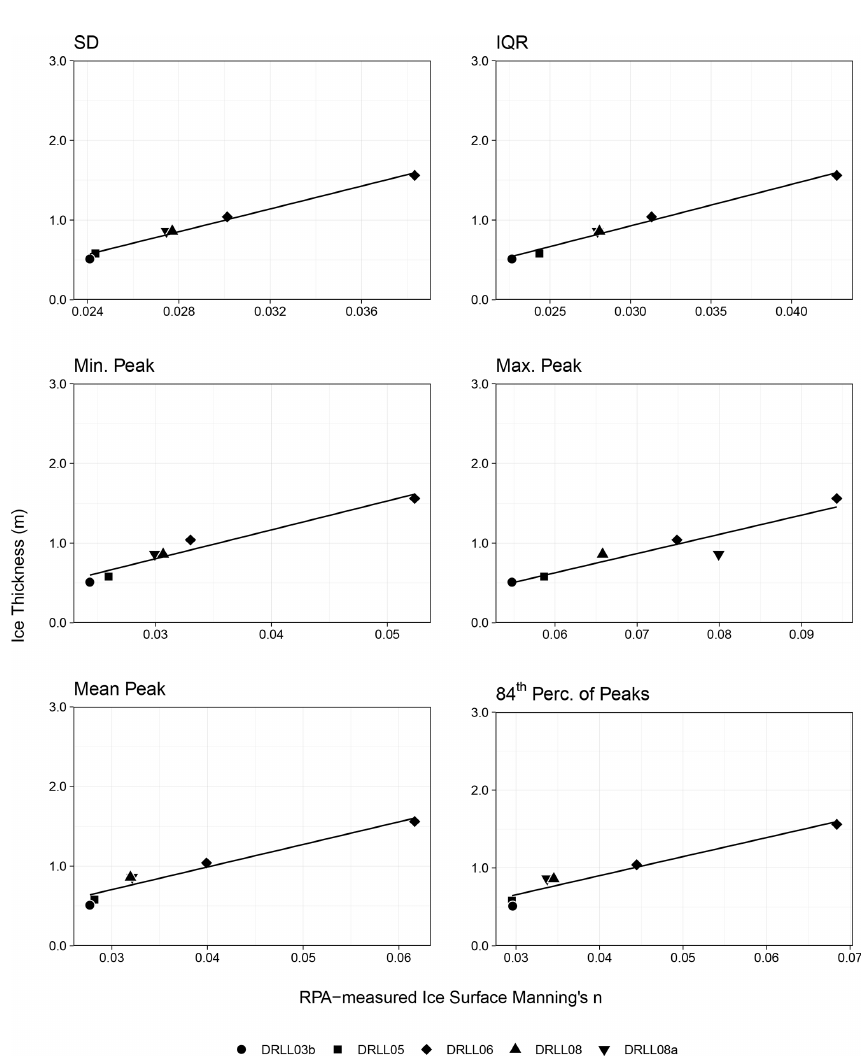
Figure 10. Comparison of RPA-measured ice surface Manning’s n calculated from various statistical metrics to site ice